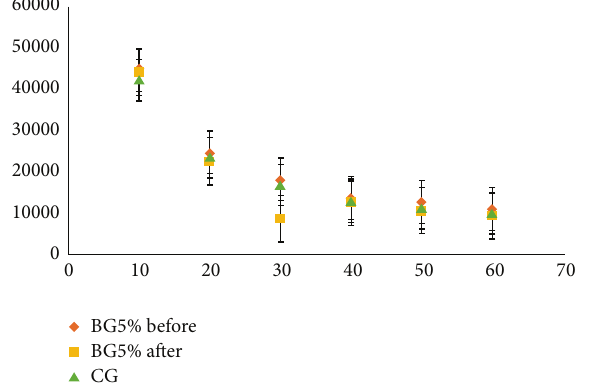
Figure 1: Effect of shear rate on the viscosity of borneol gel 5% (BG5%) before and after the freeze-thaw cycle and carbopol (cid:2) (CG) gel formulation. Values are mean ± standard